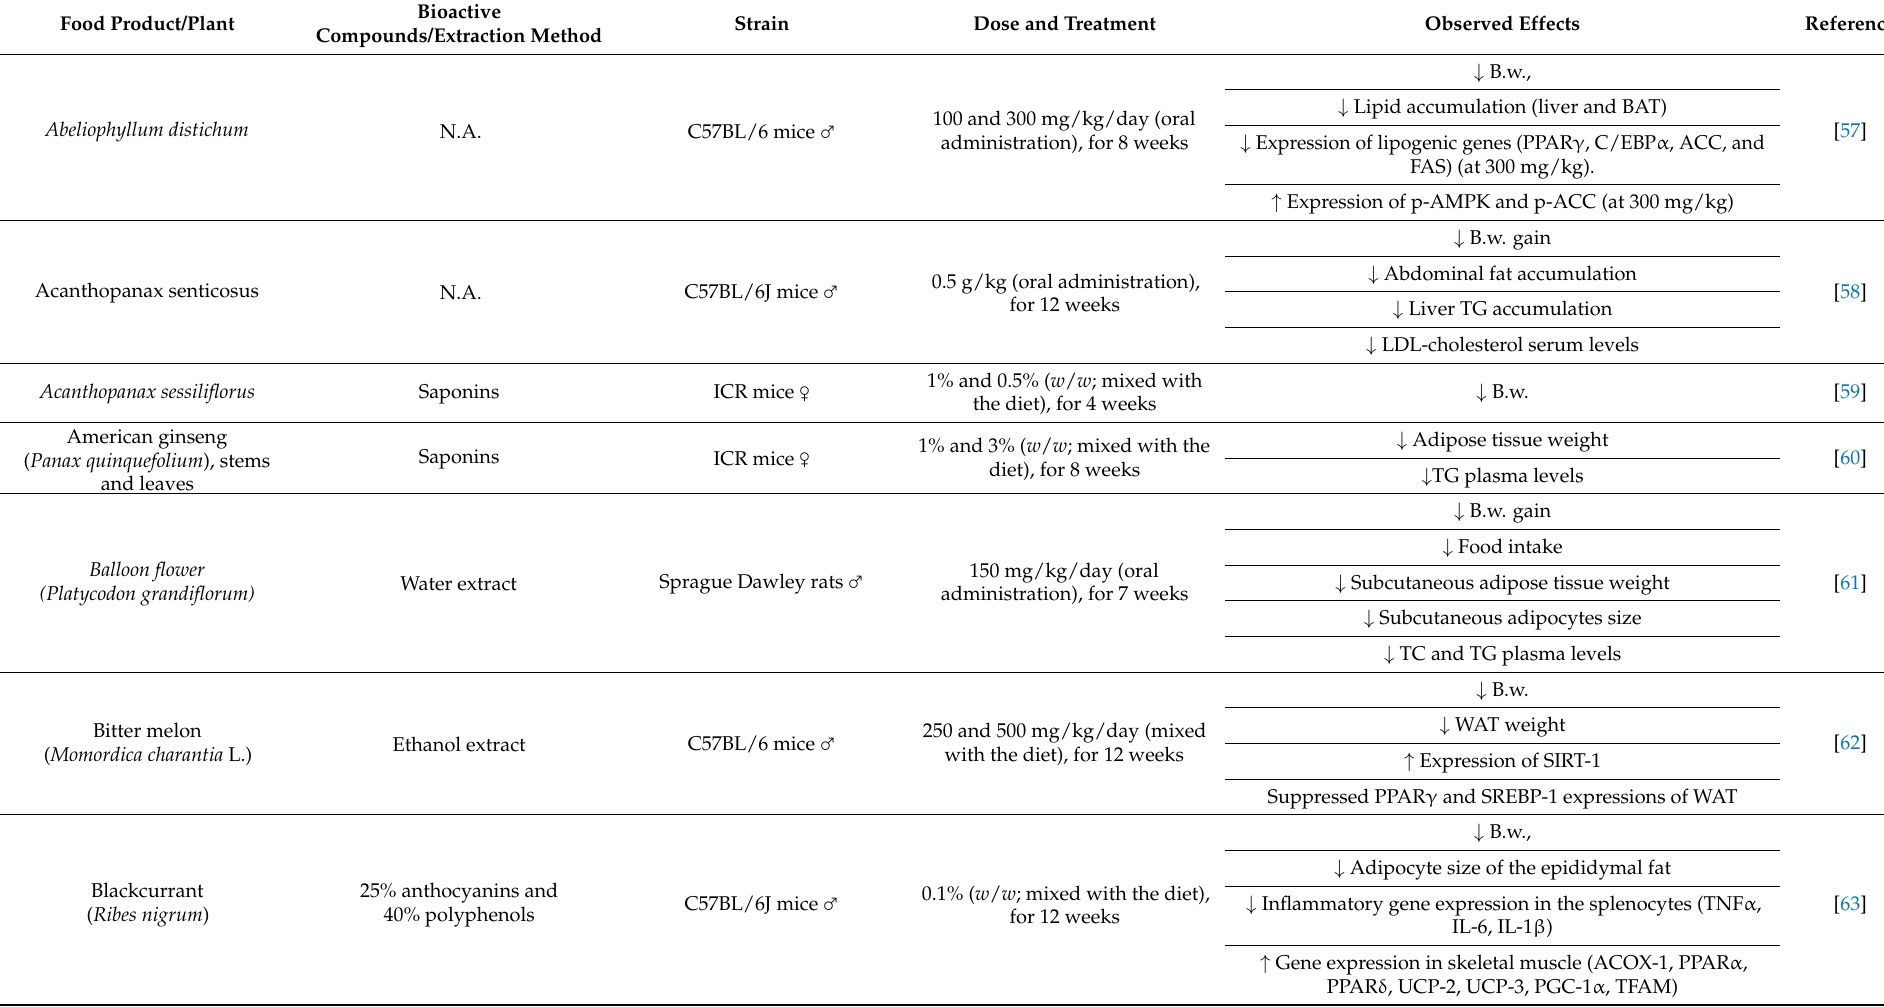
Table 2. Effects of natural products on HFD-induced obesity